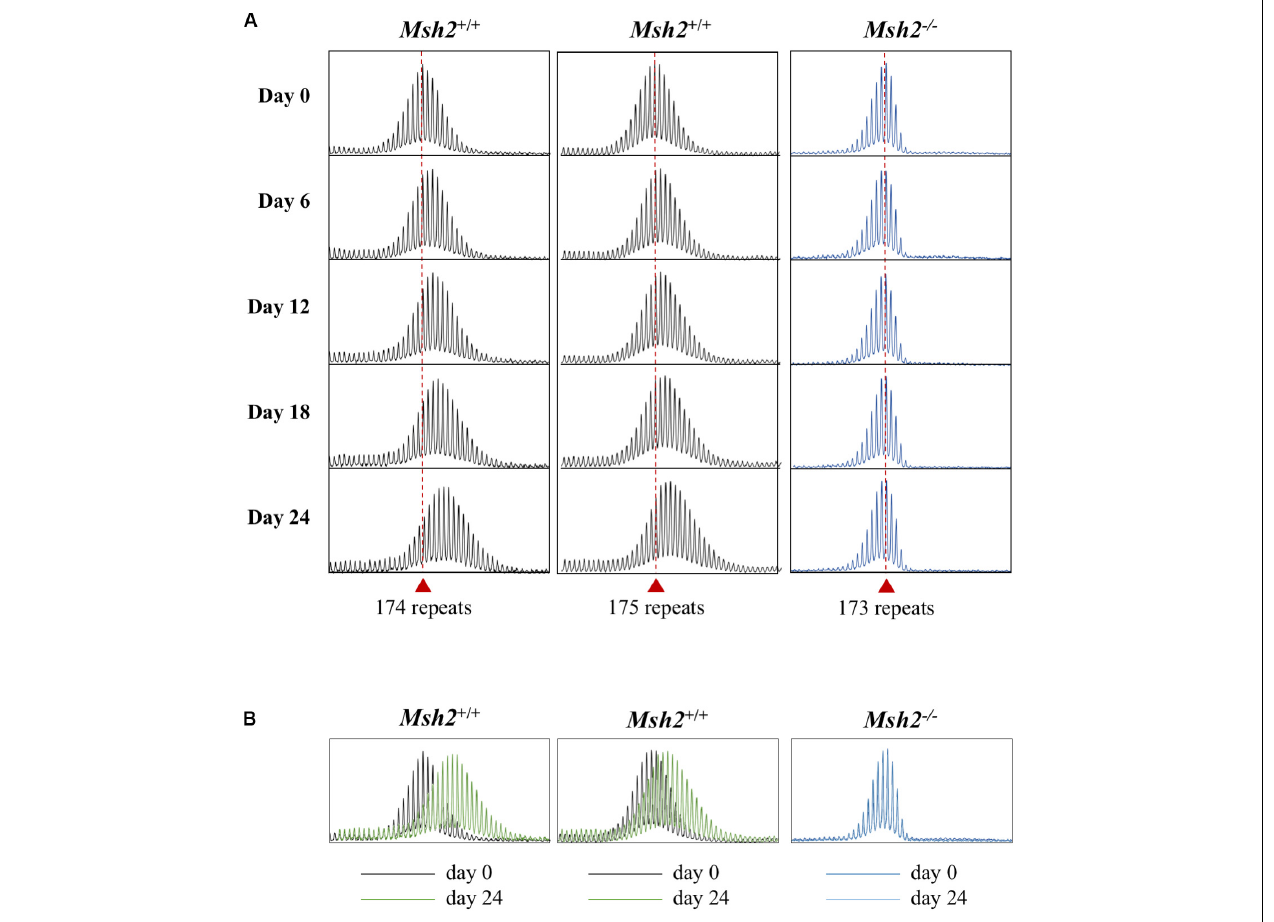
FIGURE 3 | Effect of the loss of MSH2 on repeat expansion in mESCs. (A) Representative repeat PCR profiles of the 2 Msh2 + / + and 1 Msh2 − / − lines with 173–175 repeats grown in culture for the indicated times. Dashed lines represent the initial allele at day 0. At least 2 mESC lines were tested for each genotype with similar results being obtained for each line. (B) Overlays of the day 0 and day 24 scans for each of the cell lines.